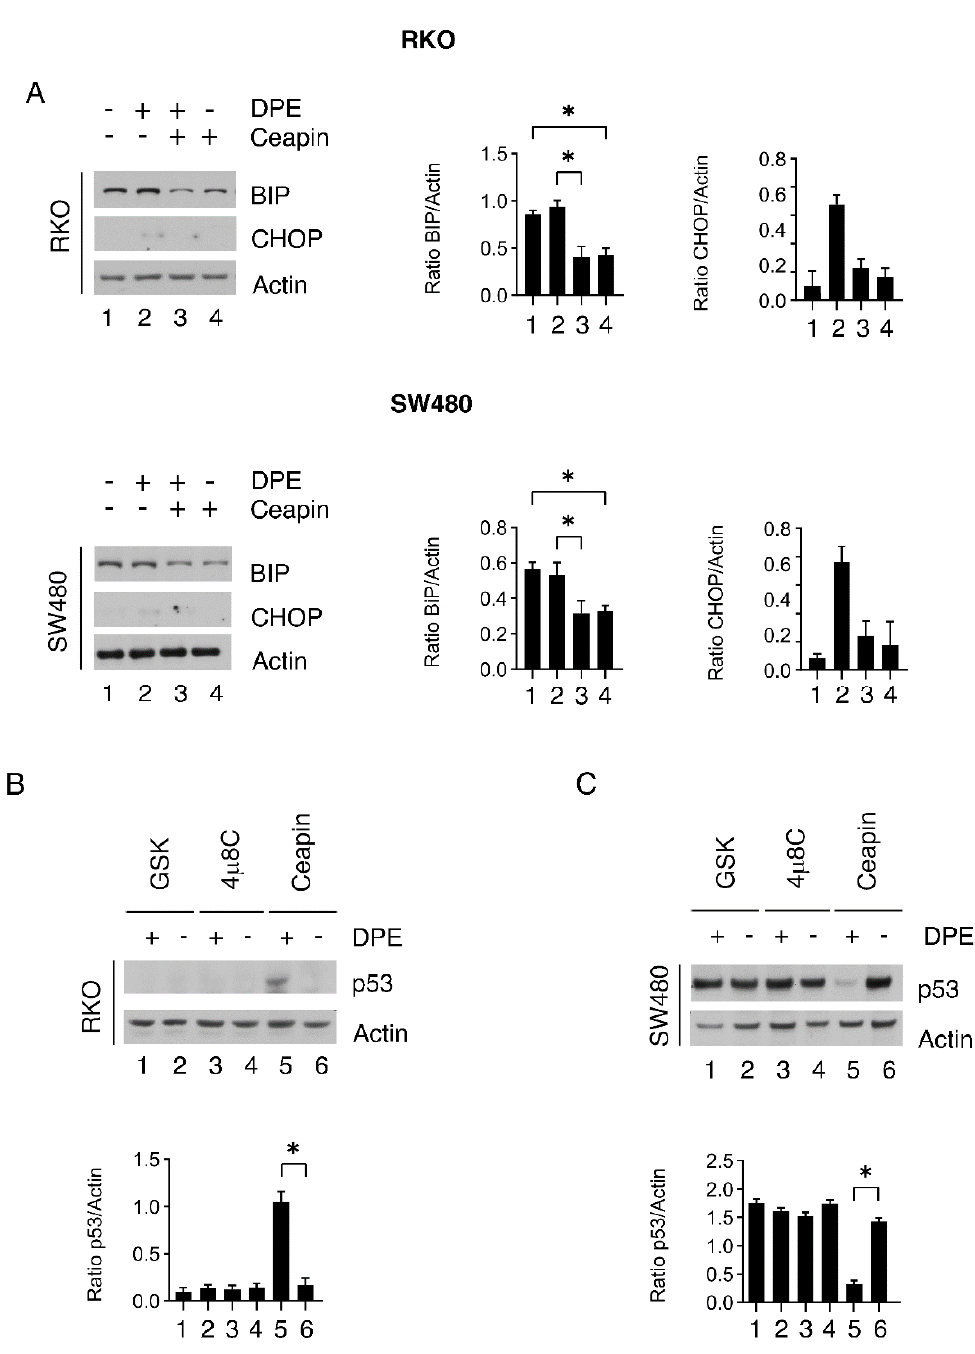
Figure 7. Inhibition of ATF6 α reduces BiP expression and leads to wtp53 activation or mut p53 reduction in wild-type and mutp53 cells, respectively. ( A ) RKO and SW480 were pre-treated with ceapin (12 µ M) and then treated with DPE (50 µ M) or left untreated as control. After 48 h, the expression of BiP and CHOP was evaluated by Western blot analysis. β -Actin was used as the loading control. The histograms represent the means plus S.D. of the densitometric analysis of the ratio between the protein and β -actin. RKO ( B ) and SW480 ( C ) were pre-treated with 4 μ 8C (10 μ M), GSK (0.5 μ M), or ceapin (12 μ M) and then treated or not with DPE (50 μ M). After 48 h, the expression of p53 was evaluated via Western blot analysis. β -Actin was used as the loading control. The histograms represent the means plus S.D. of the densitometric analysis of the ratio between the protein and β -actin. Note: * p < 0.05.